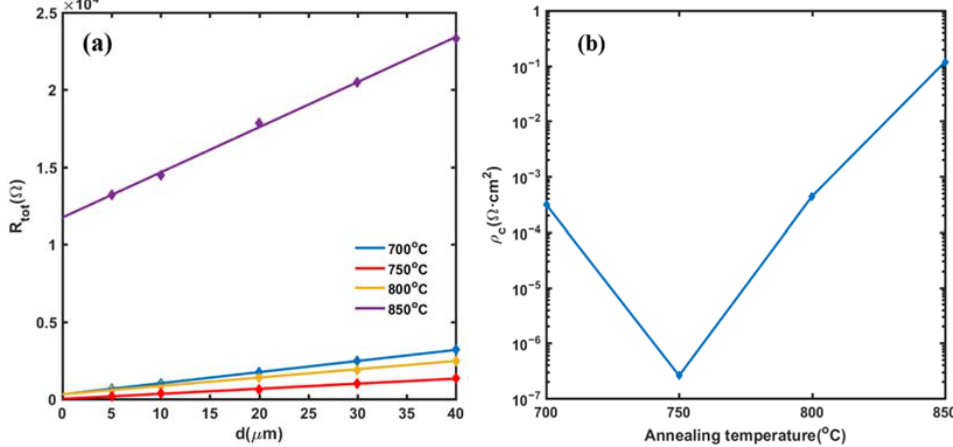
Figure 8. ( a ) The total resistance with the change of the distance between side ohmic contact TLM electrodes. ( b ) The specific contact resistance with the change of annealing temperature.